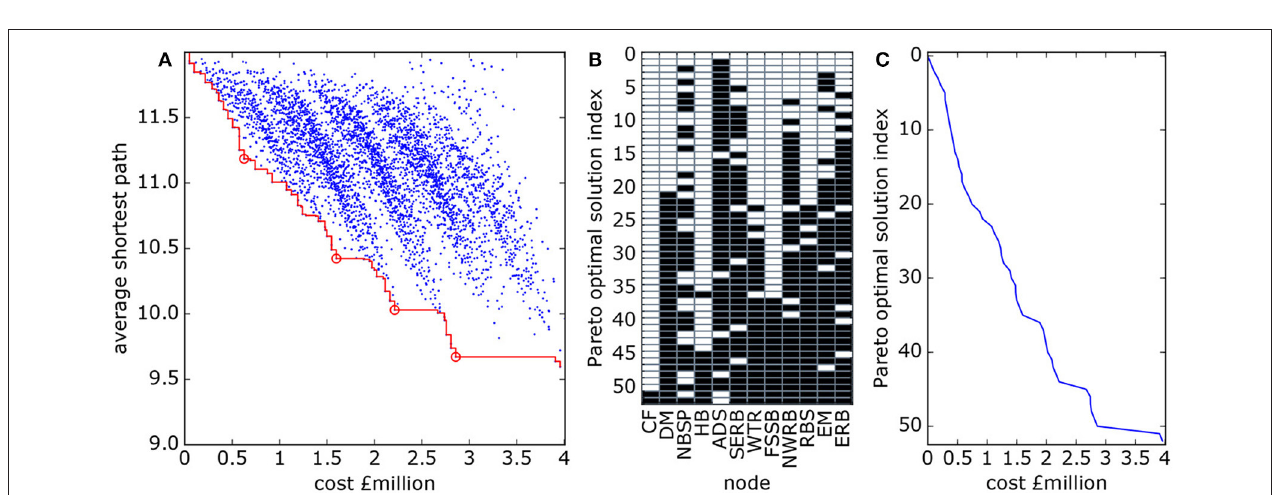
FIGURE 6 | (A) Cost and average shortest path length for all subnetworks of the Scottish MPA network shown in Figure 3 (blue dots). The red line links the Pareto optimal points. The open circles indicate the locally “better” solutions—lower cost and shorter average shortest path—on the Pareto front. Panels (B,C) are the composition (B) and cost (C) of the Pareto optimal subnetworks as described for Figure 5 . Site name abbreviations (x-axis in B ) are listed in Table 1